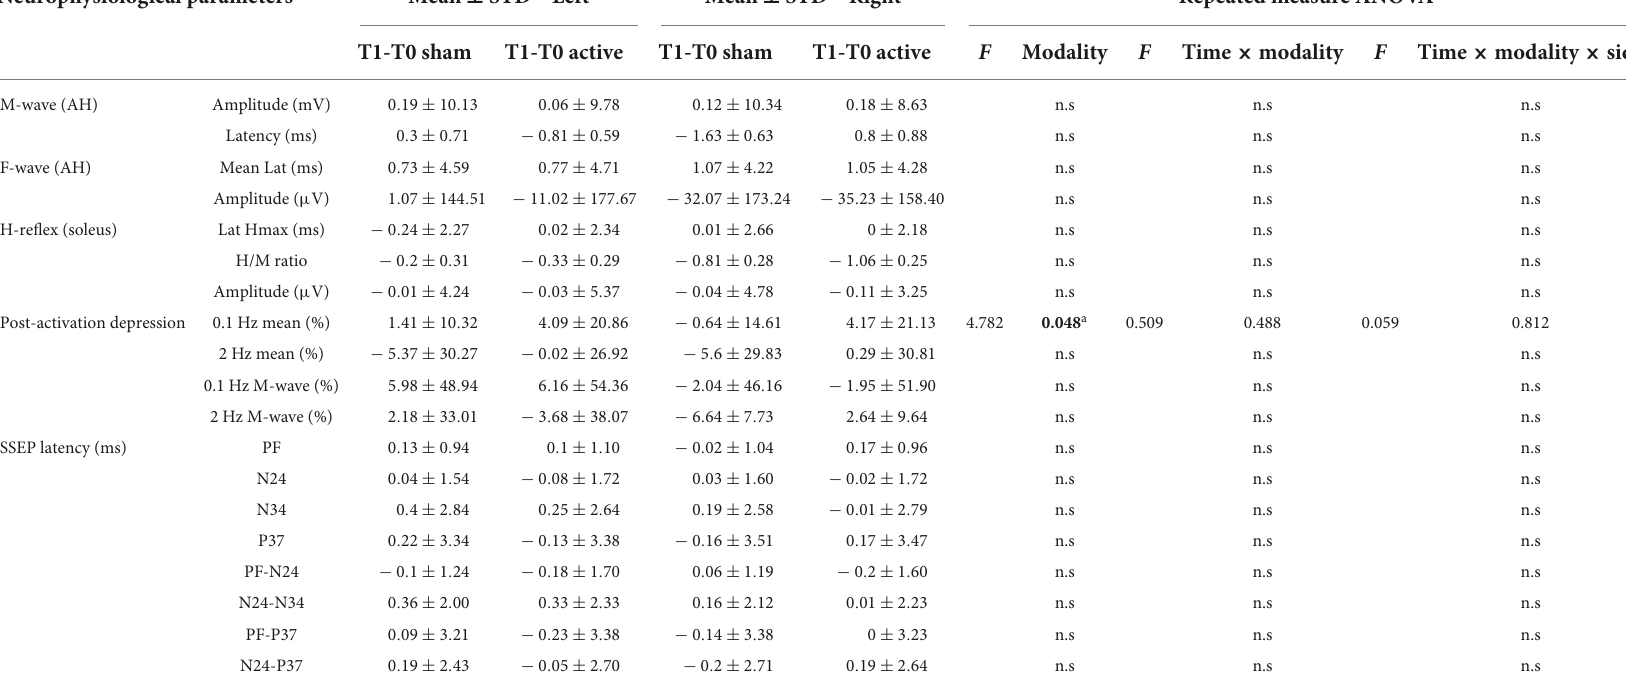
TABLE 3 Differences of the neurophysiological responses for lower limbs between T1 and T0 moment ( N = 14). Neurophysiological